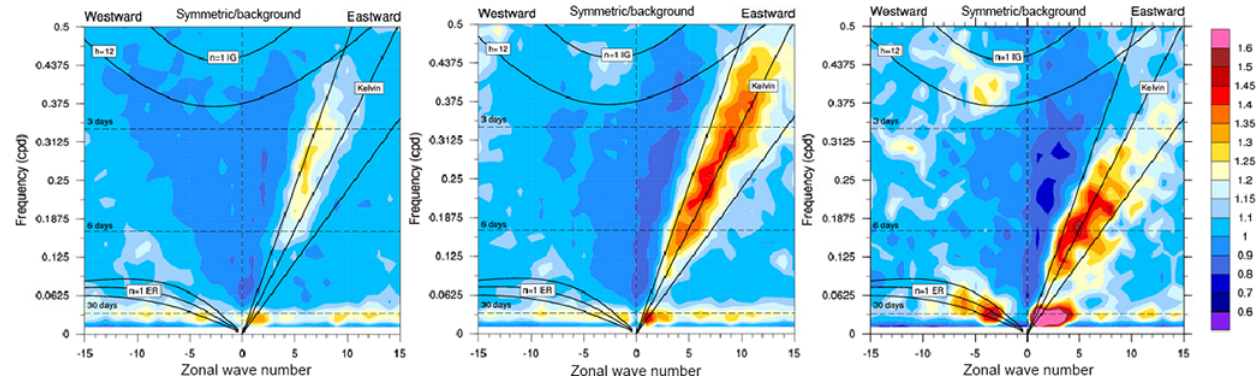
Figure 13. Tropical power spectra derived from surface precipitation fields between 15 ◦ S and 15 ◦ N (following Wheeler and Kiladis, 1999) for GA4.0 (left), GA6.0 (centre) and as observed from TRMM (Tropical Rainfall Measuring Mission; Huffman et al., 2007) data (right). Model data are from 20-year N96 atmosphere/land-only climate simulations.